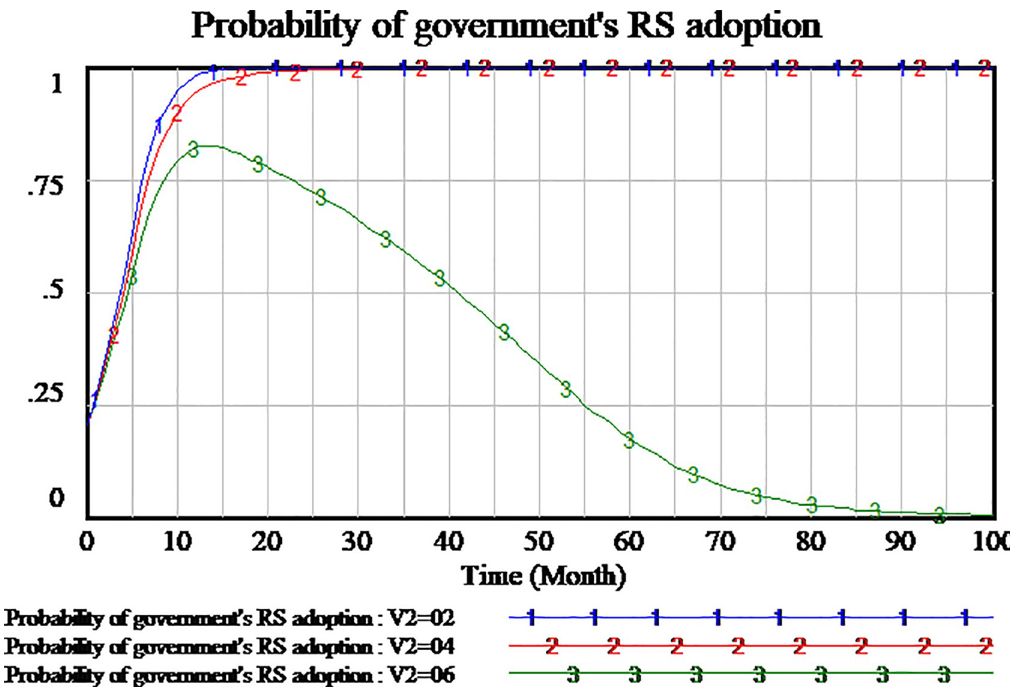
Fig 14. Impact of different compensation on government.